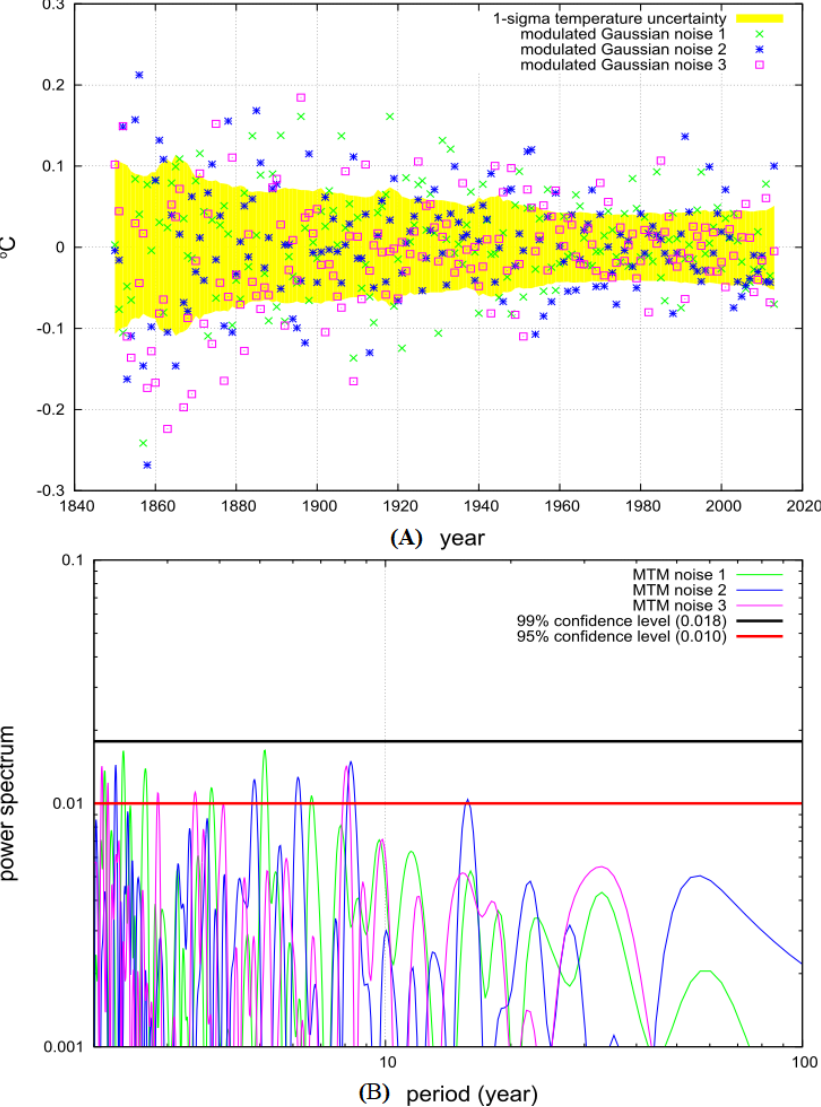
Figure 2. ( A ) 1 σ global surface temperature confidence based on the net bias, measurement, sampling and coverage error uncertainty (yellow area) [37] and three computer-generated Gaussian noise records with a variable standard deviation modulated on the temperature uncertainty. ( B ) Power spectra of the three computer-generated Gaussian noise records with their 95% and 99% average confidence level using the Multi-Taper Method (MTM)